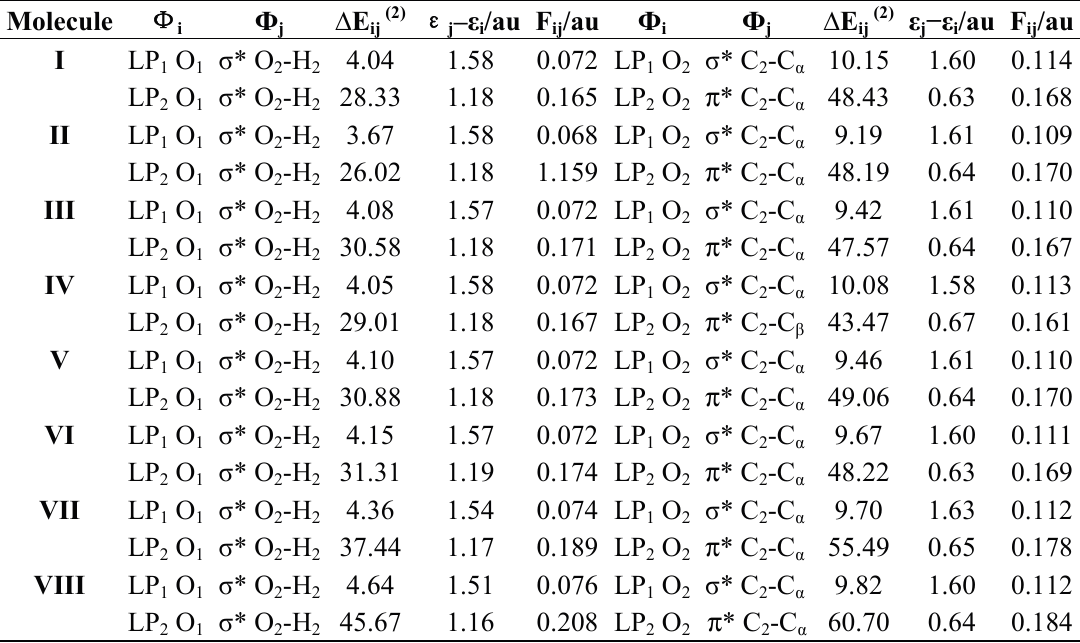
Table 4. Stabilization energies (kcal/mol) for selected NBO pairs (donor-acceptor) given by second order perturbation energies of the Fock matrix in the NBO basis for the